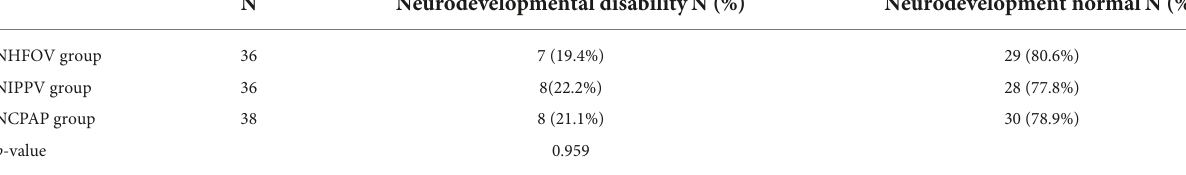
TABLE 3 Neurodevelopmental impairment at 24-month CA. Neurodevelopmental disability N